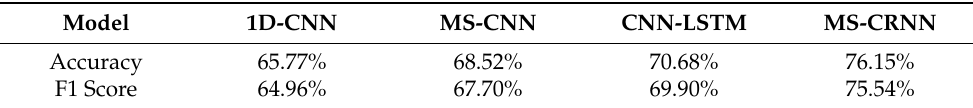
Table 6. Results of the experiment under noisy conditions.